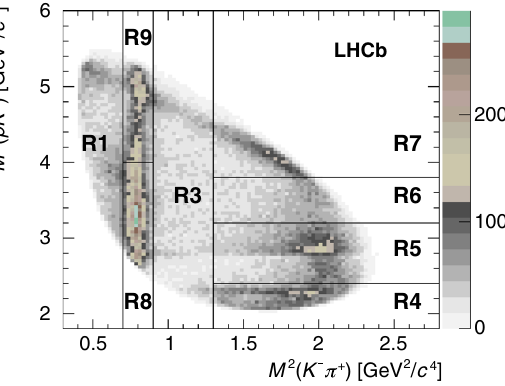
Fig. 3 Definition of the Dalitz plot regions for (left) Λ + c → pK − π + and (right) Ξ + c → pK − π + decays. Additional regions are defined by combining regions. For Λ + c → pK − π + R2 = R5 ∪ R6 and for Ξ + c →